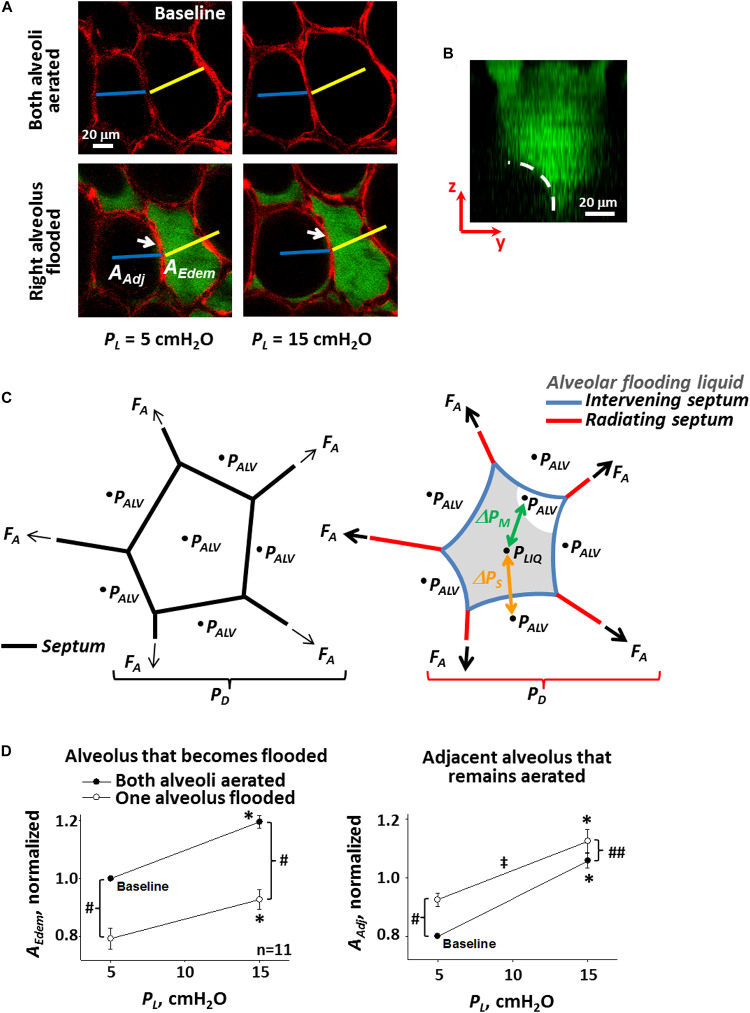
Single alveolar edema model. (A) Inflation and flooding effects on alveolar geometry. Optical sections of two surface alveoli in isolated, perfused rat lungs. Epithelium labeled with calcein red-orange. Transpulmonary pressure, PL, as indicated. In bottom images, right alveolus flooded with fluorescein-labeled 5% albumin solution. Air appears black. Sections are 2-μm thick and at 20-μm sub-pleural depth. Flooding right alveolus causes bowing of central “intervening” septum that separates aerated and flooded alveoli (arrows). Scale bars from baseline image are superimposed on all other images. Right alveolus that becomes flooded and left alveolus that remains aerated have areas AEdem and AAdj, respectively. (B) Meniscus in flooded alveolus. Image is y–z section, constructed from confocal z-stack, of an alveolus flooded with fluorescein-labeled 5% albumin solution. Pleural surface is at top of image. Epithelium is unlabeled and, along with air, appears black. Dashed line shows meniscus at mouth of flooded alveolus. (C) Schematics of alveolus before (left) and after (right) liquid flooding. Intervening septa separate aerated from flooded alveoli. Radiating septa are directed outward from flooded alveolus and have aerated alveoli to each side. PALV is alveolar air pressure. PLIQ is flooding liquid pressure. Air–liquid interface in flooded alveolus forms a meniscus. ΔPM = PALV – PLIQ is pressure drop across meniscus. ΔPS = PALV – PLIQ is pressure drop across intervening septa. Axial distending force FA acts at ends of sectioned septa and is greater in radiating septa around flooded alveolus on the right than in normally-stressed septa around aerated alveolus on the left. Ratio of summed FA over alveolar surface is an effective distending pressure PD applied to central alveolus. (D) Alveolar compliance. Alveolar areas plotted vs. PL for pairs of adjacent alveoli, one of which becomes flooded as in (A). Slope of lines is a two-dimensional analog of compliance. Statistics: ∗Area greater at PL of 15 than 5 cm H2O (p < 0.01), for state before or after one alveolus is flooded. #Area different after than before one alveolus is flooded, at constant PL (p < 0.01). ##Same as “#” but p < 0.02. ‡Slope less after than before one alveolus is flooded (p < 0.01). (A,B,D) Modified, with permission, from Perlman et al. (2011).